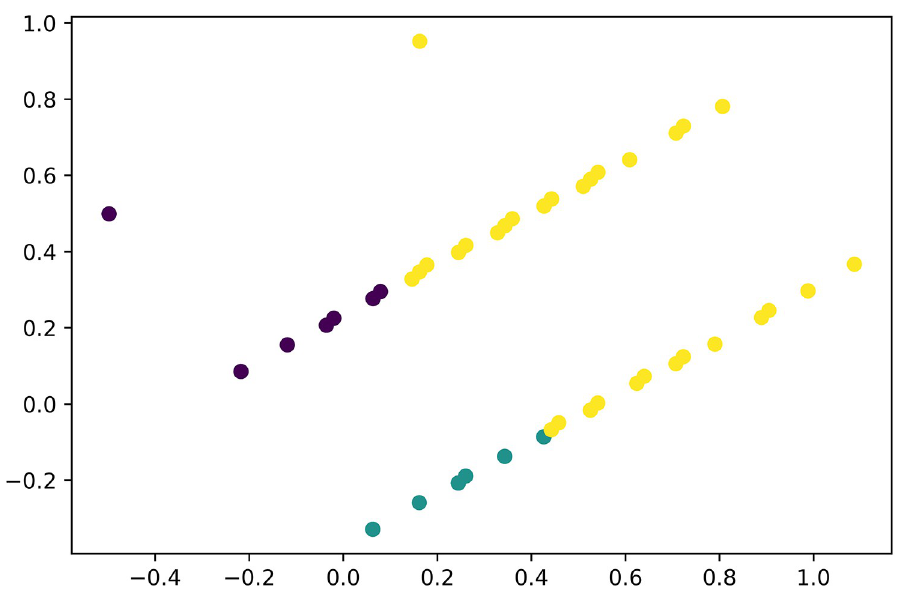
Fig 3. K-Means clustering.